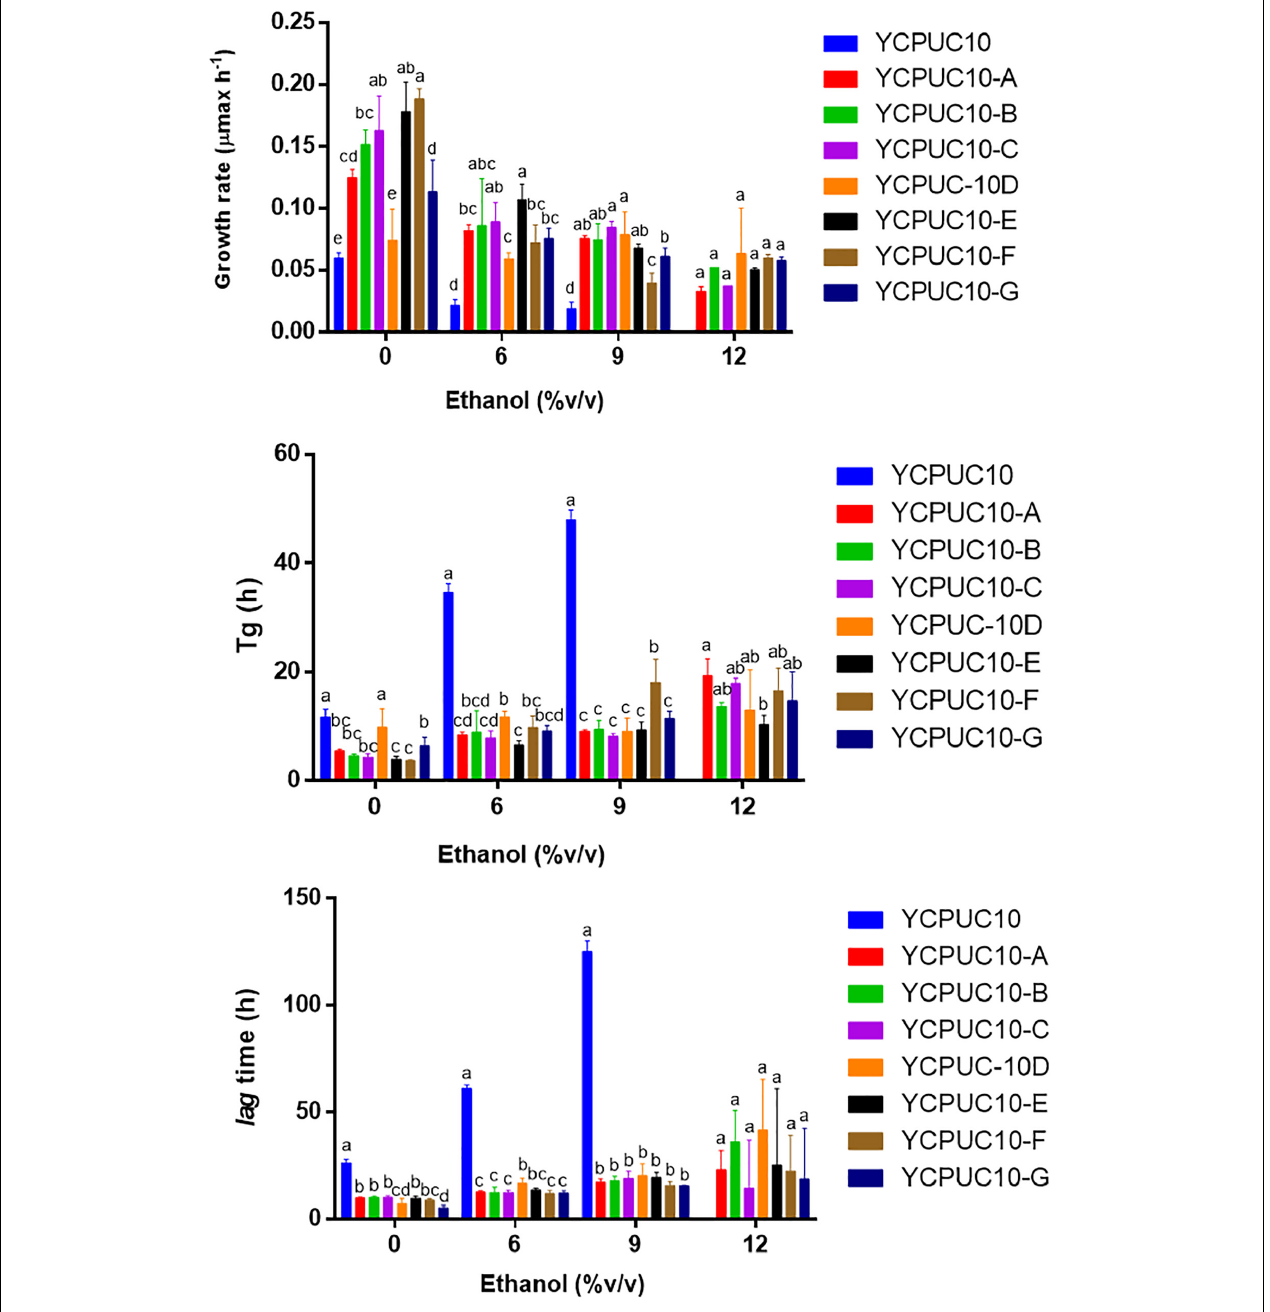
FIGURE 3 | Growth kinetic parameters of T. delbrueckii YCPUC10 and evolved strains in YPD broth with different concentrations of ethanol. Mean ± SD ( n = 3). Different letters above bars represent significant differences between clones at a given ethanol concentration (LSD p ≤ 0.05).